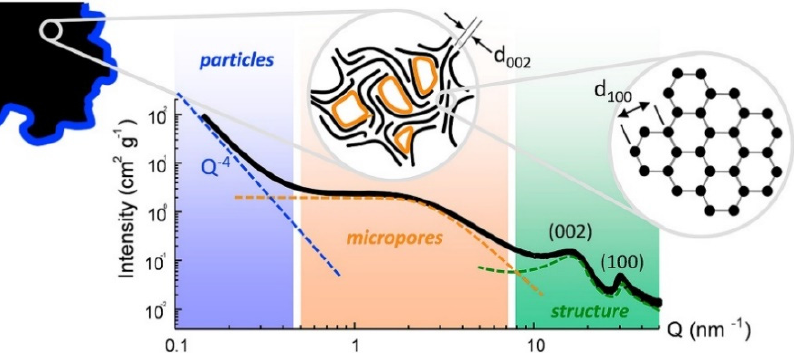
Figure 23. Typical SAXS curve representing intensity versus scattering vector, together with schematic